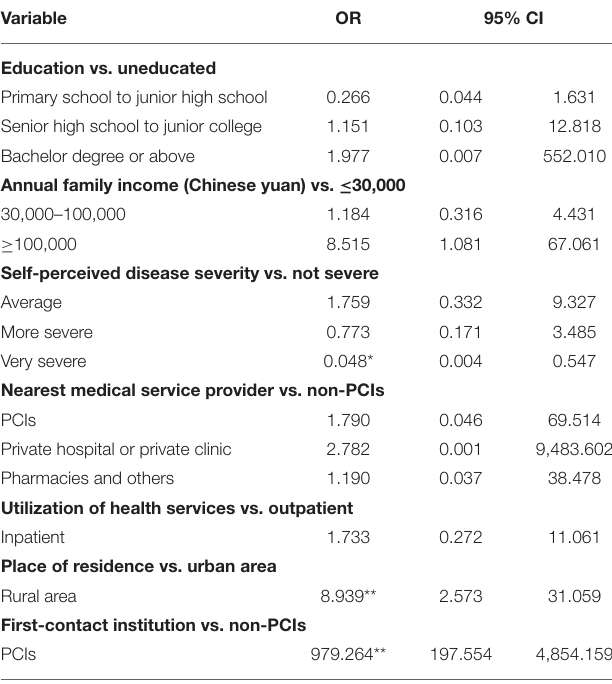
TABLE 5 | Binomial logistic regression analysis of factors influencing first-contact willingness.